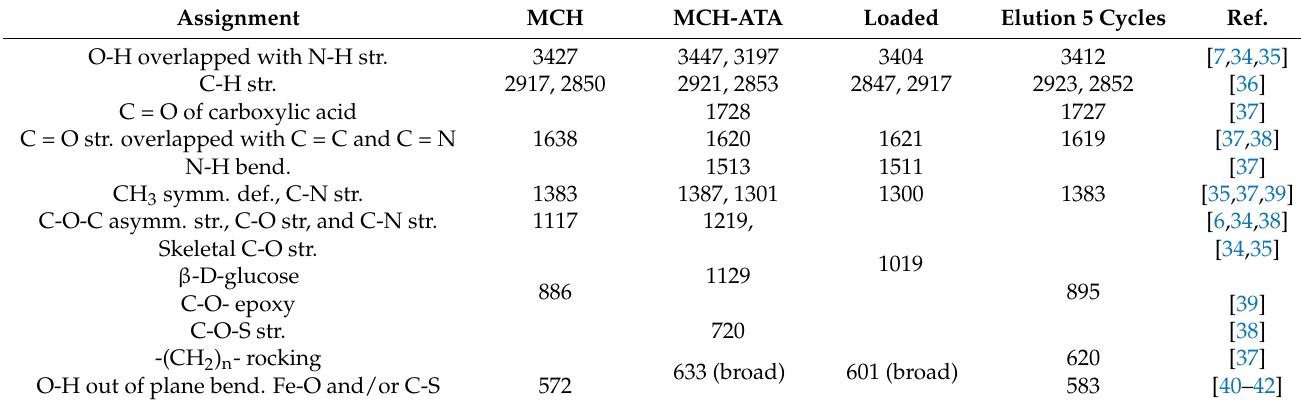
Figure 3. FTIR analysis of sorbents MCH and MCH-ATA at different stages of sorption and after 5 cycles of sorption desorption processes. Table 1. Assignments of FTIR peaks for MCH, MCH-ATA (before and after Cd(II) sorption, and after 5 cycles of sorption and